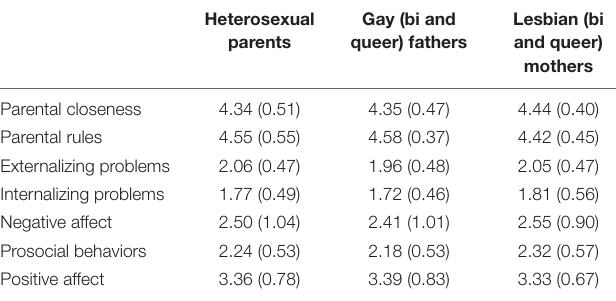
TABLE 4 | Comparisons across family groups on parenting behaviors and children’s psychosocial